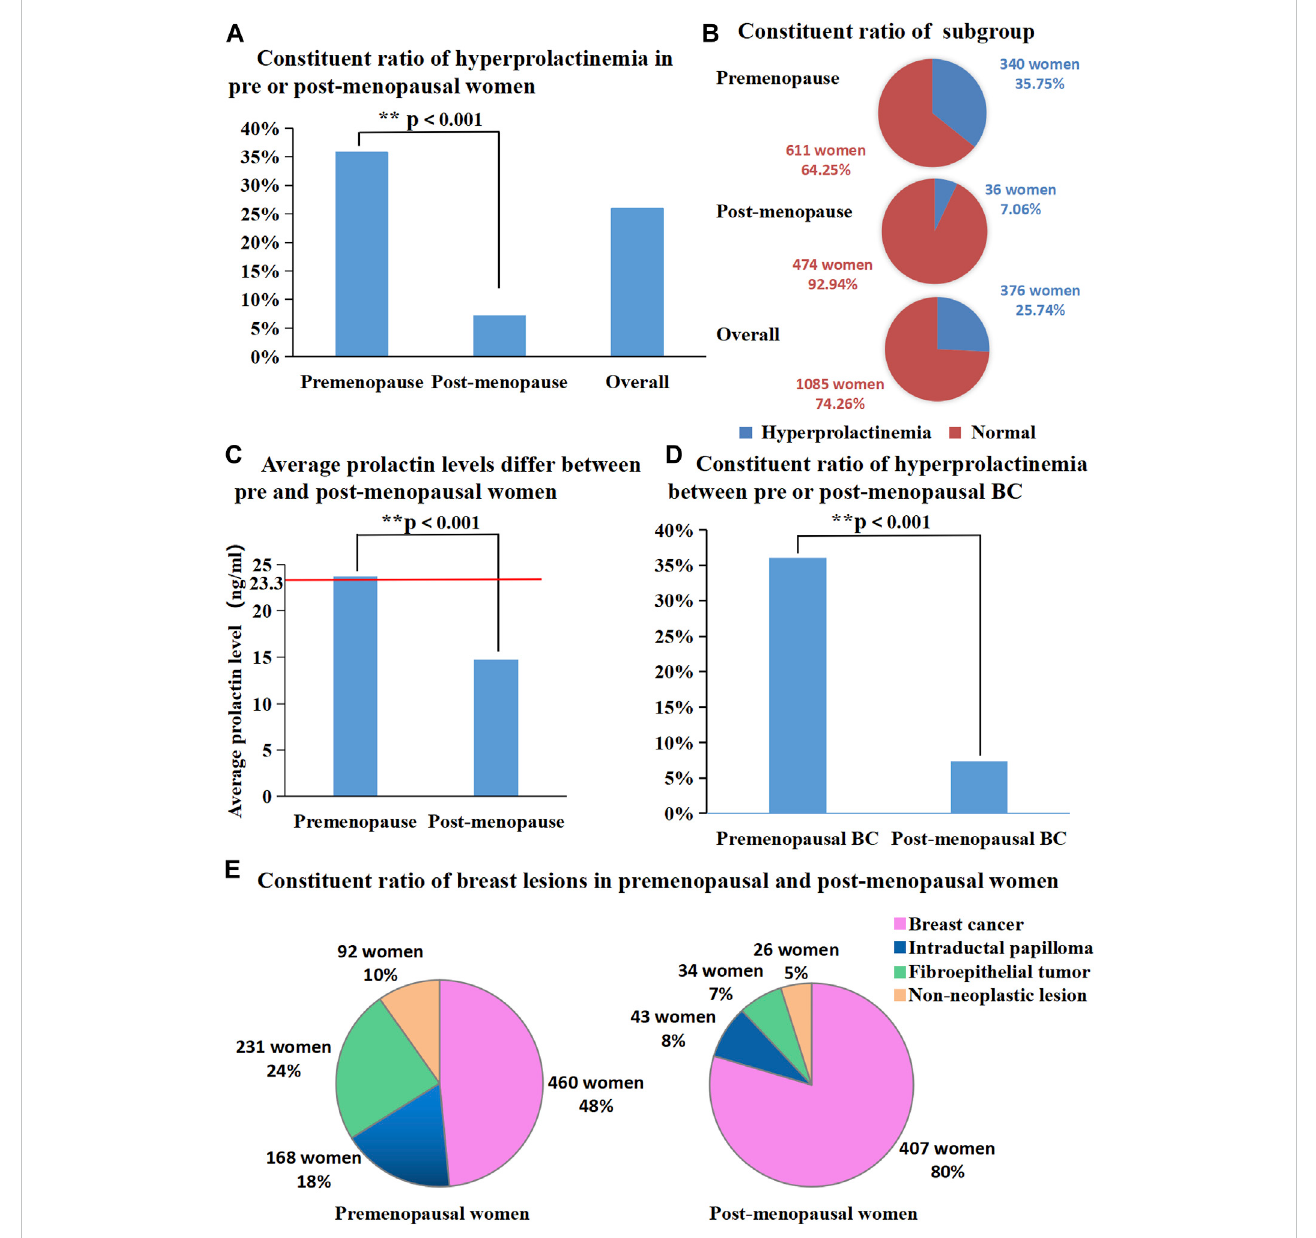
FIGURE 1 (A) Proportion of hyperprolactinemia was signi fi cantly different between pre and post-menopausal women (35.75% vs. 7.06%, p < 0.001); (B) Proportion of each subgroup (number of people with or without hyperprolactinemia); (C) Average prolactin levels were signi fi cantly different between pre and post- menopausalwomen(23.72 ng/mLvs.14.79 ng/mL, p < 0.001); (D) Proportionofhyperprolactinemiabetweenpreorpost-menopausalbreastcancerpatients. (E) Proportion of breast diseases in premenopausal and post-menopausal